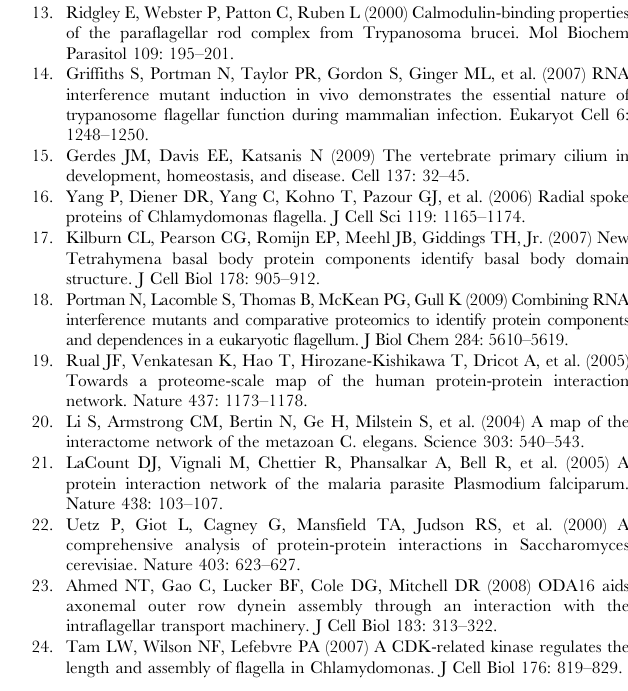
Figure S2 Auto-activation assay of PFR baits. A. Cartoon illustrating that some ORFs fused with the Gal4 DNA binding domain have the ability to activate the transcription of the reporter genes.This behaviour has to be tested to decrease the false positive rate. B. The diagram shows the position of each DB-ORF for this assay. C. Readout of the four autoactivation assays (b-galactosi- dase assay, auxotrophic media lacking histidine and complement- ed with 20 and 60 mM 3AT and media lacking the uracil amino acid. PFC11, PFC2, PFC20 are strong auto-activators in all assays. PFC3 and PFR5 are weak auto-activators. Found at: doi:10.1371/journal.pone.0007685.s002 (0.06 MB PDF) Table S1 PCR primers used to generate the ORFeome. AttB1 and AttB2 recognition sequences are shown in lower case. Found at: doi:10.1371/journal.pone.0007685.s003 (0.01 MB